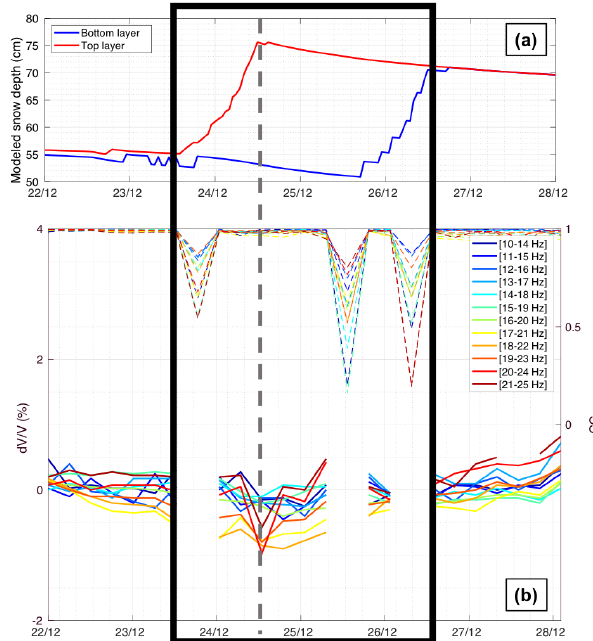
Figure 5. Observations during the snowfall event 0 (SF0), with the modeled depth of each snow layer from SNOWPACK simulations (a) , and d V/V measurements at different frequency bands, with corresponding CC values in dashed lines (b) . When the correlation coefficient (CC) is too low (CC < 0 . 8), d V/V values are considered outliers and then removed. The frame in black shows approximately the whole period of interest, whereas the dashed grey line highlights precisely the state of the medium with corresponding observables just after the